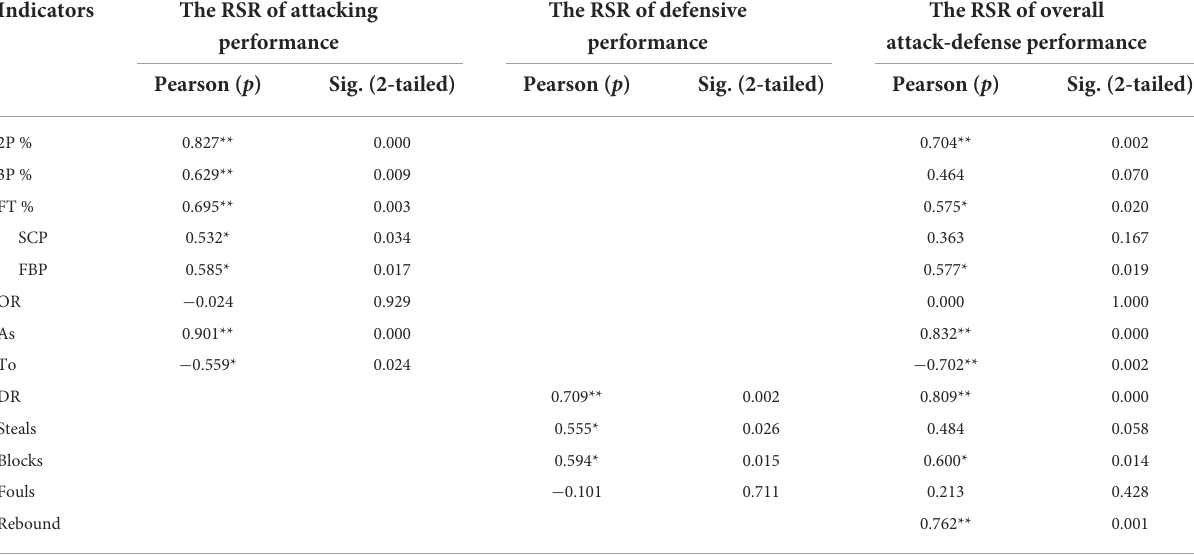
TABLE 8 Correlation between performance indicators and the attack-defense